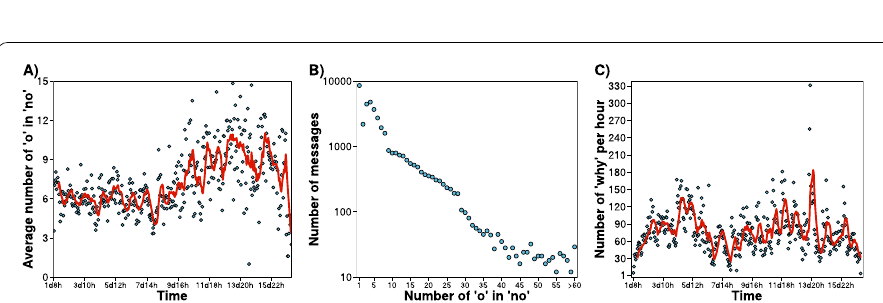
Figure 6 start9 protests throughout the game. Left: fraction of input corresponding to the start9 command. Right: fraction of users sending start9 who where in the original start9 riot (inset, total number of protesters each day). There were start9 protests 10 days after the first one even though less than 10% of the protesters had been part of the first one